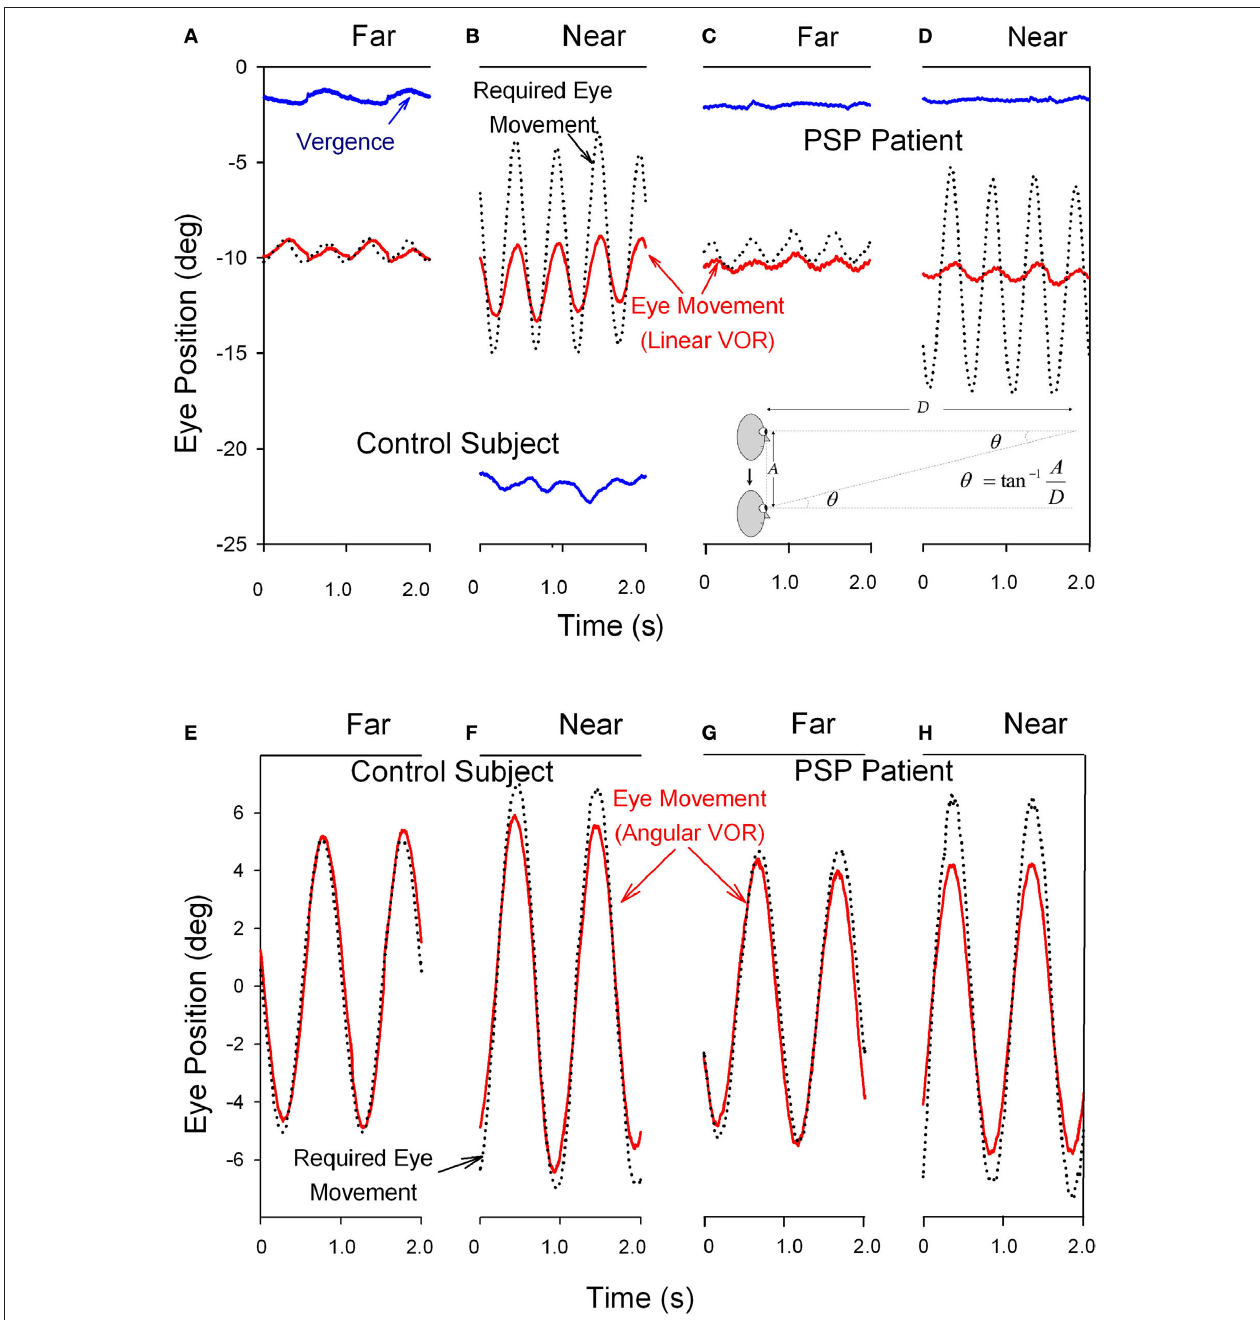
Figure 6 | Comparison of the vertical linear or translational (bob) vestibulo-ocular reflex (tVOr) in the top panels and the horizontal angular (yaw) vestibulo-ocular reflex (aVOr) in the lower panels from a normal elderly subject (A,B,e,F) and a patient with PSP (C,D,g,H). When the normal subject viewed the far target (A) , vertical eye movements (red line) due to tVOR were appropriately small; during near viewing (B) , when the subject converged (blue line), they increase, although not as much as would be required to hold the foveal line of sight on the visual target (black dotted line). When the PSP patient subject viewed the far target (C) , vertical eye movements due to tVOR were small; during near viewing (D) , the patient neither converged nor increased the tVOR response. The normal subject shows near-perfect aVOR during far viewing (e) ; during near viewing